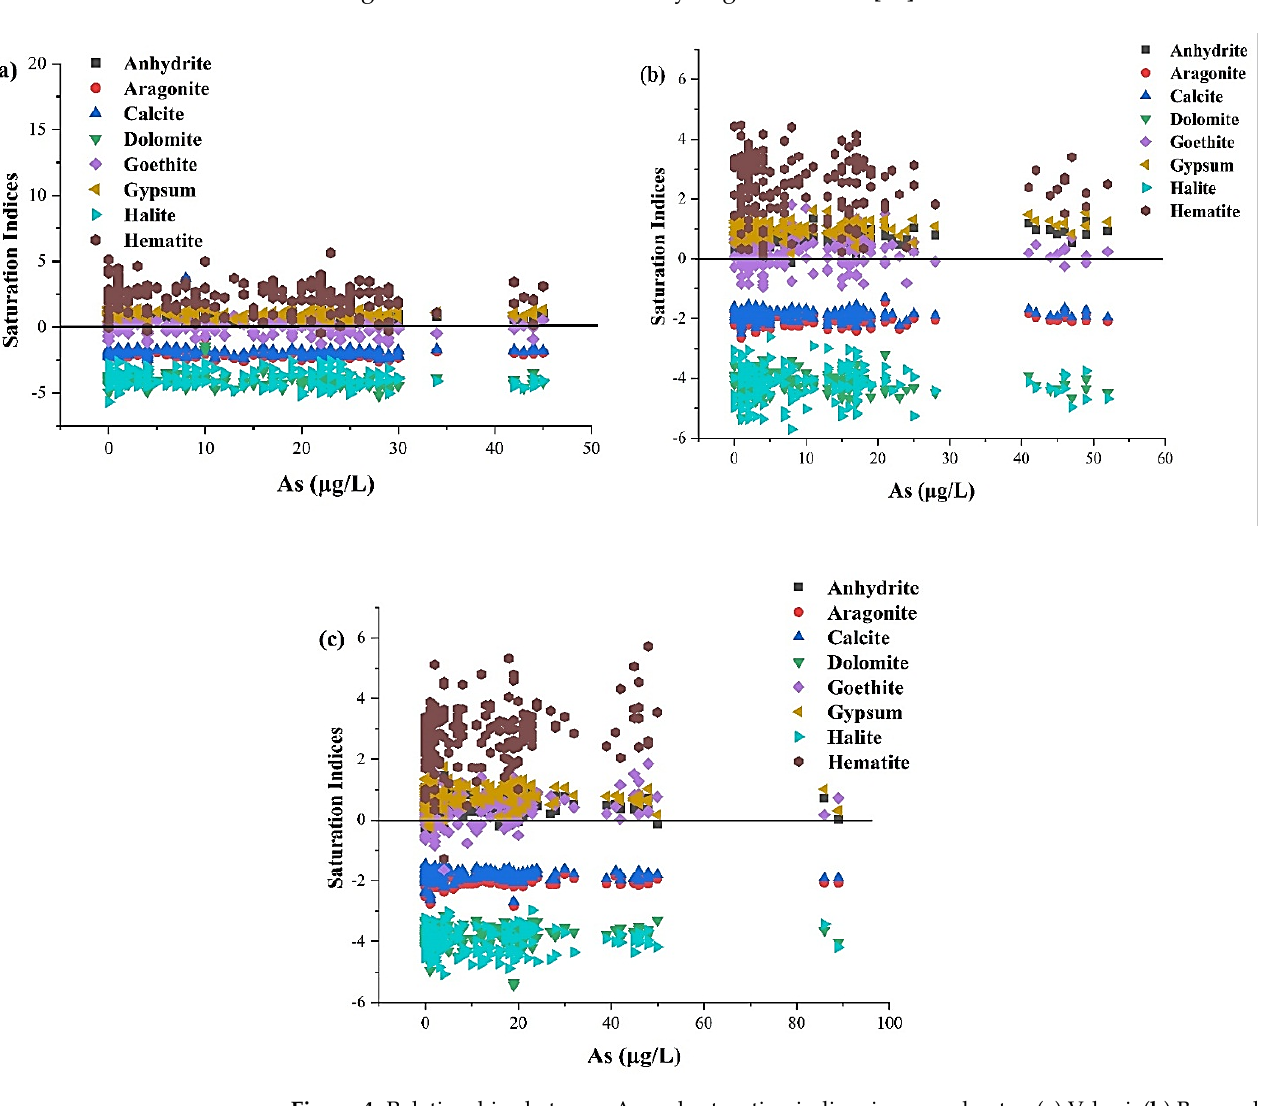
Figure 4. Relationships between As and saturation indices in groundwater. ( a ) Vehari, ( b ) Burewala, and ( c ) Mailsi.